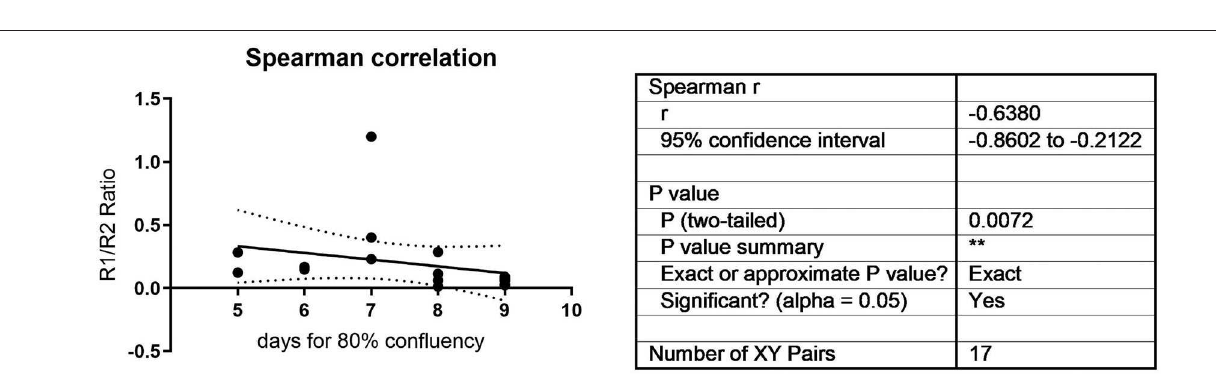
FIGURE 4 | Time to 80% confluency was correlated to the TGFBR1/ TGFBR2 ratio. A statistically significant negative correlation was observed (r = − 0.638, P =